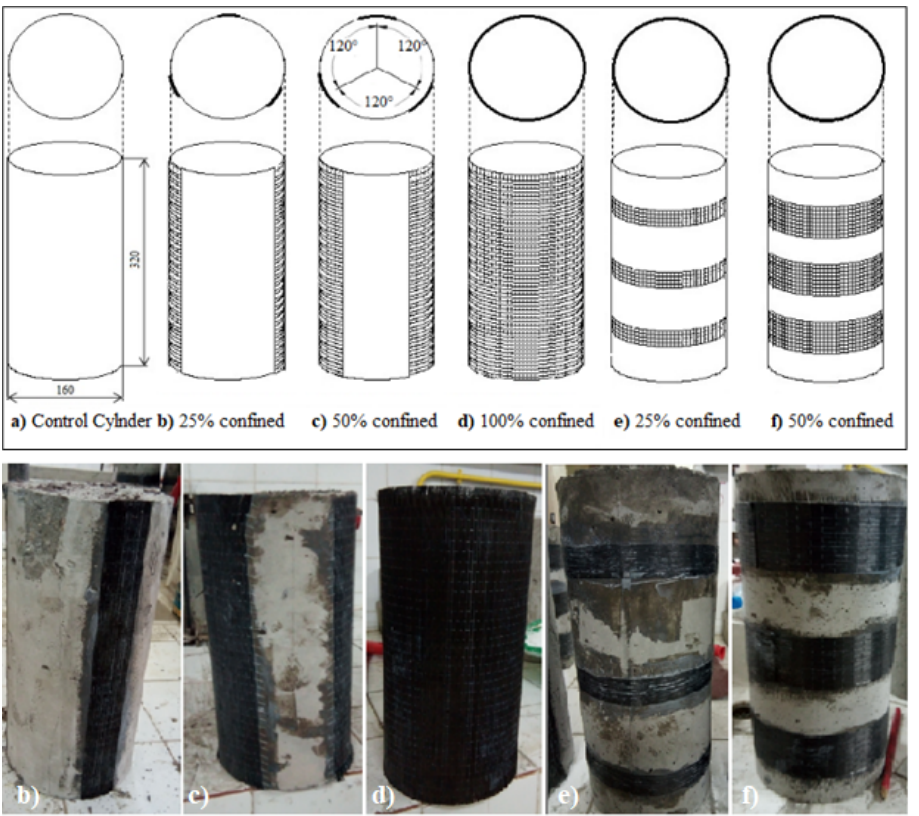
Figure 2. Various confinement (wrapping) configurations: ( a ) control cylinder CC; ( b ) quarter confined longitudinal QCL; ( c ) half confined longitudinal HCL; ( d ) totally confined longitudinal TCL; ( e ) quarter confined transversal QCT; and ( f ) half confined transversal HCT.